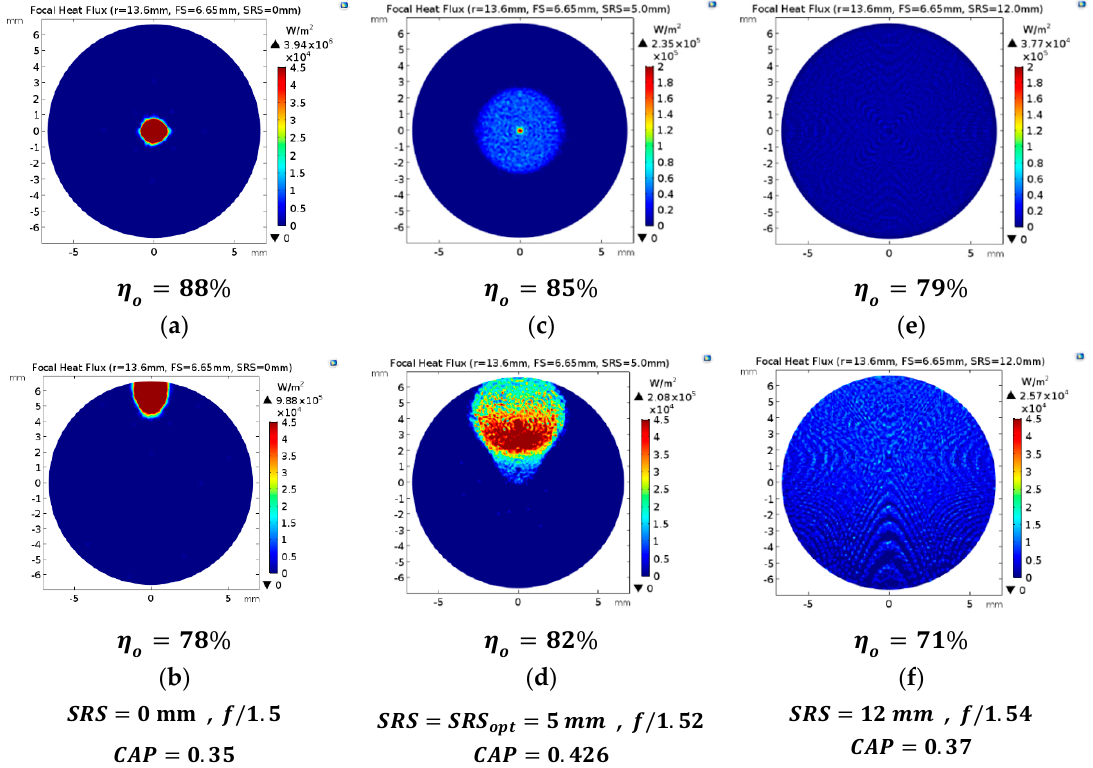
Figure 8. Case 1 receiver’s irradiance distribution in W/m 2 at an incidence angle and an SOE–receiver spacing (SRS), respectively, of ( a ) normal and 0 mm, ( b ) 1.0° and 0 mm, ( c ) normal and 5 mm, ( d ) 1.0° and 5 mm, ( e ) normal and 12 mm, and ( f ) 1.0° and 12 mm. (Optical efficiencies are indicated below each figure; the f-number was taken with respect to the receiver.)